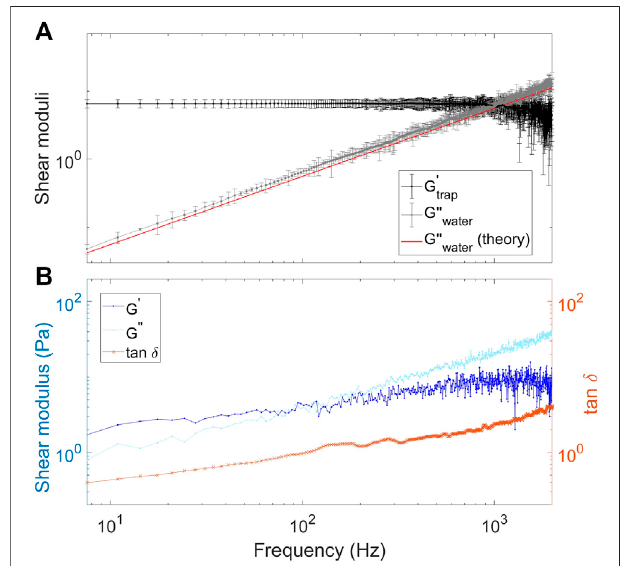
FIGURE 3 | Extraction of complex shear moduli for tracer particles in water or Matrigel solutions. (A) Extracted complex shear moduli for a bead trapped in water. The black symbols and black line show the storage modulus. The gray symbols and gray line show the loss modulus, the results being in agreement with theory (red line) for a viscous liquid. (B) Extracted storage modulus, G ′ (blue), and loss modulus, G ″ (light-blue), for a bead trapped in a Matrigel solution (75 medium:25 Matrigel). Both G ′ and G ″ increase as a function frequency. At low frequencies, the Matrigel solution exhibits solid-like behavior. At around 100 Hz the loss modulus equals the storage modulus, and at frequencies higher than 100 Hz the solution exhibits liquid like behavior. The orange line shows the loss tangent which is below or above 1 for solid- or liquid-like behavior,